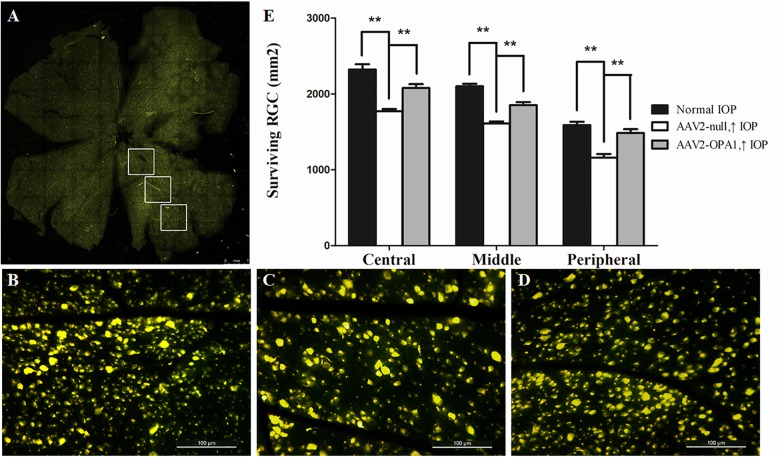
FluoroGold labeling of surviving RGCs in the hypertensive rat retina after overexpression of OPA1. Flat-mounted retinas of AAV2-OPA1-transfected hypertensive rat (A,D), control rat (B), and AAV2-null-transfected hypertensive rat (C). Quantification of RGC survival (E). n = 6, data are expressed as mean ± SD, ∗∗P < 0.01. Scale bar = 1 mm (A), Scale bar = 100 μm (B–D).